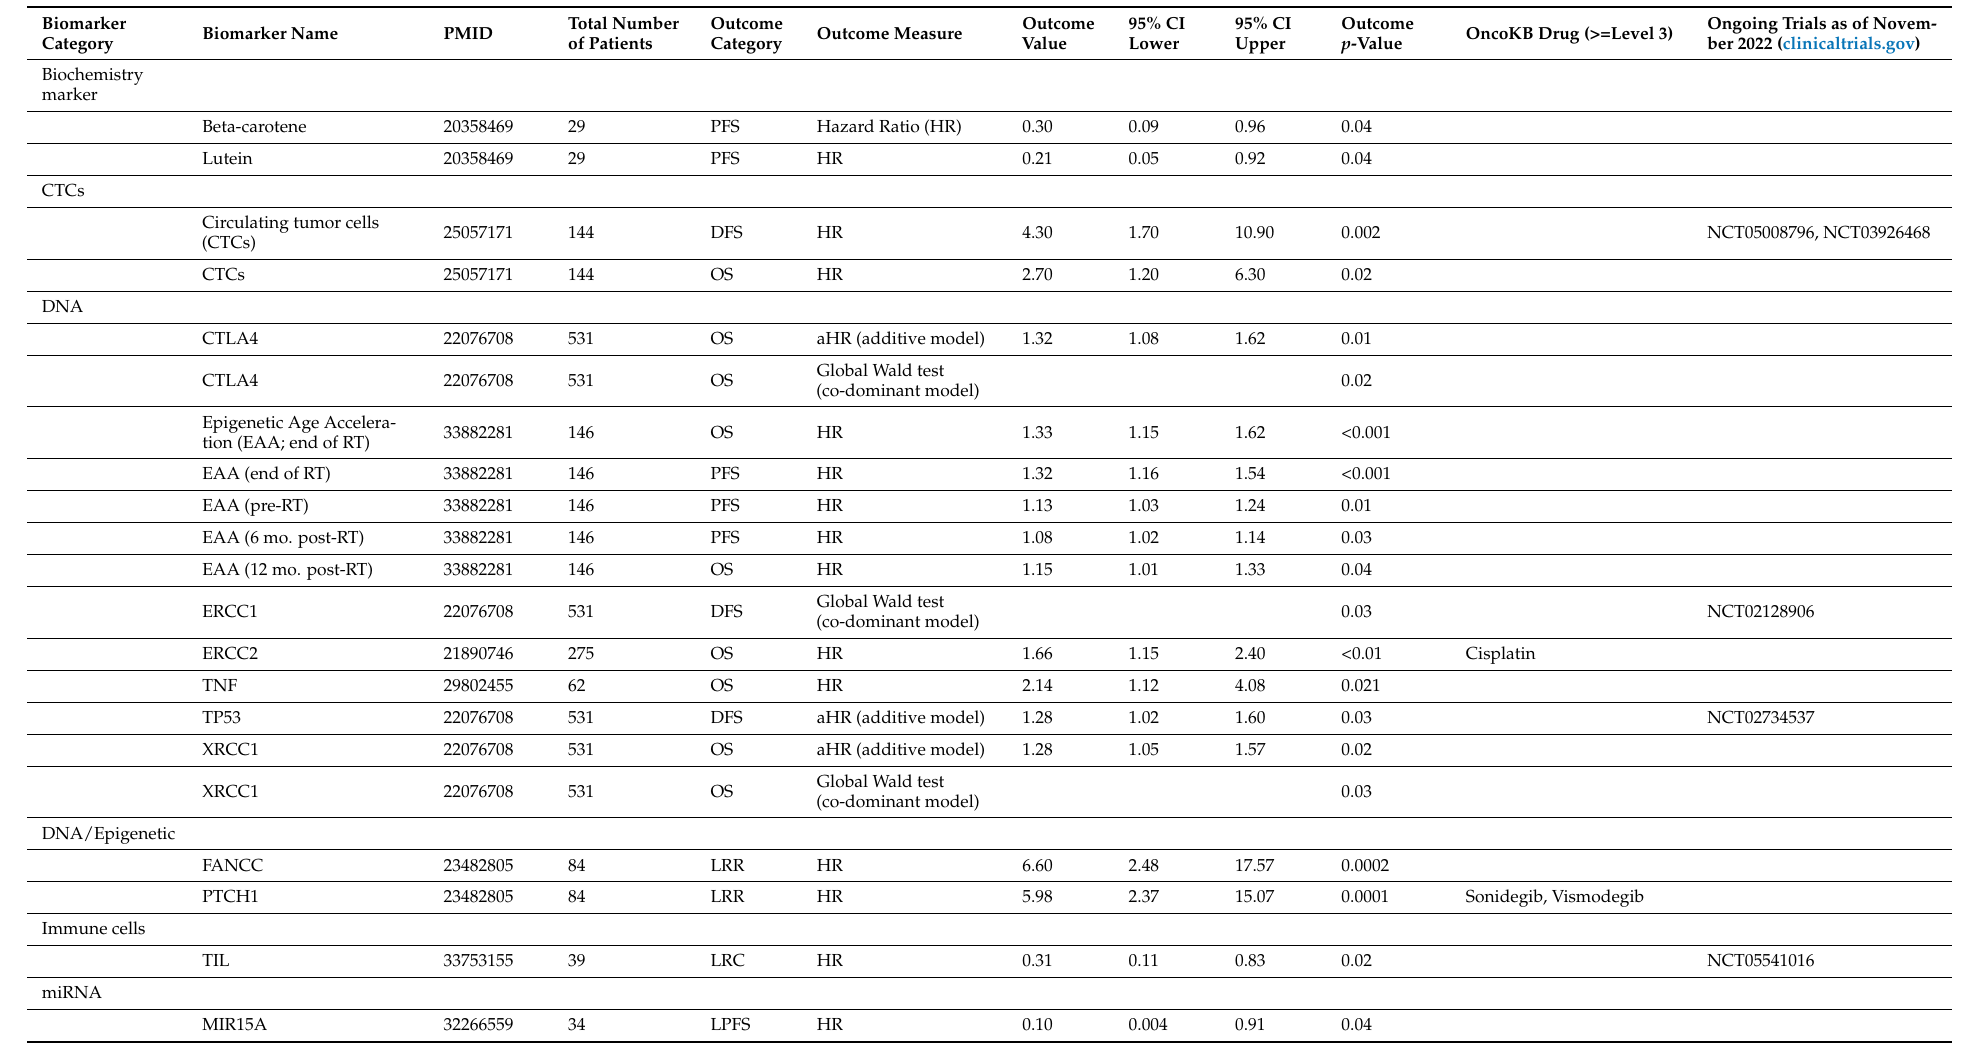
Table 1. Biomarkers with statistically significant association to outcomes in multivariate analysis, OncoKB data and currently ongoing trials (clinicaltrials.gov